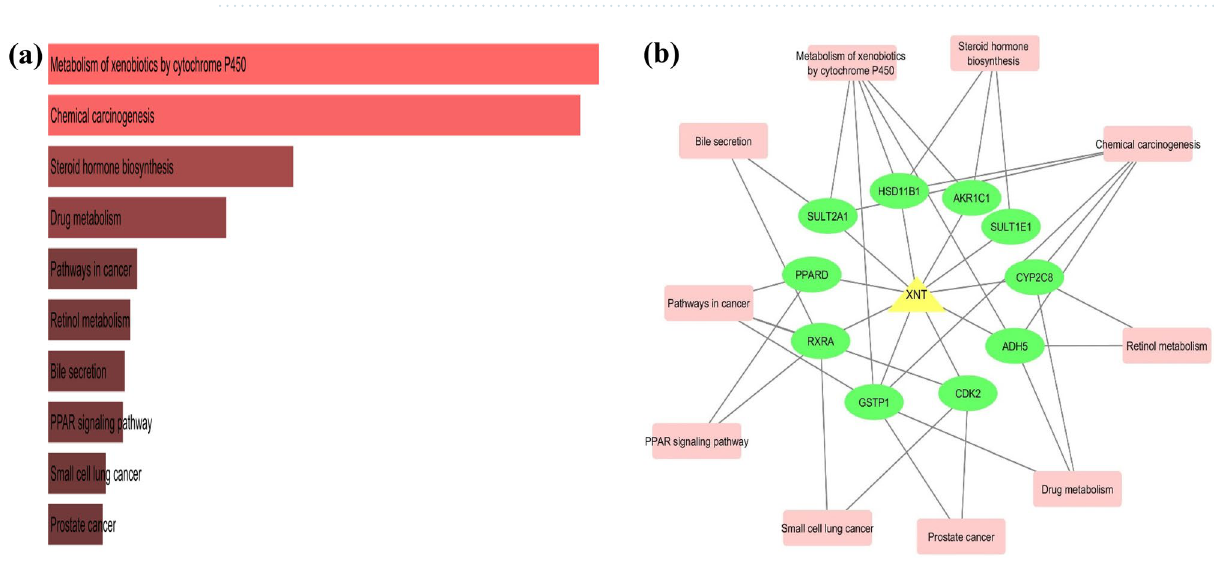
Figure 3. ( a ) Bar plot of KEGG analysis showed top ten enriched pathways . ( b ) Drug-target-pathway network constructed by cytoscape illustrated top ten pathways and their associated